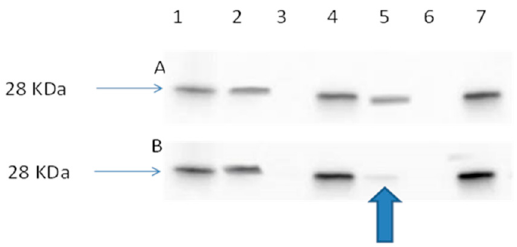
Figure 8. ( A ) Immunoblot image of lung cancer cell line (A549), control cells and (A549) cell line treated with blank 10% PEG-PLGA NP. Immunoblot positive control, (lane 1). A549 control cell lysate, (Lane 2). A549 control cell lysate after spiking with GDP (worked as negative control), (Lane 3). A549 control cell lysate after spiking with GTP γ S (worked as positive control), (Lane 4). A549 cell lysate after treatment with blank NP, (Lane 5). A549 cell lysate after treatment with blank NPs and spiking with GDP, (Lane 6). A549 cell lysate after treatment with blank NPs and spiking with GTP γ S, (Lane 7). ( B ) Immunoblot image of A549 cells treated with free NT 3–12 peptide and A549 cells treated with